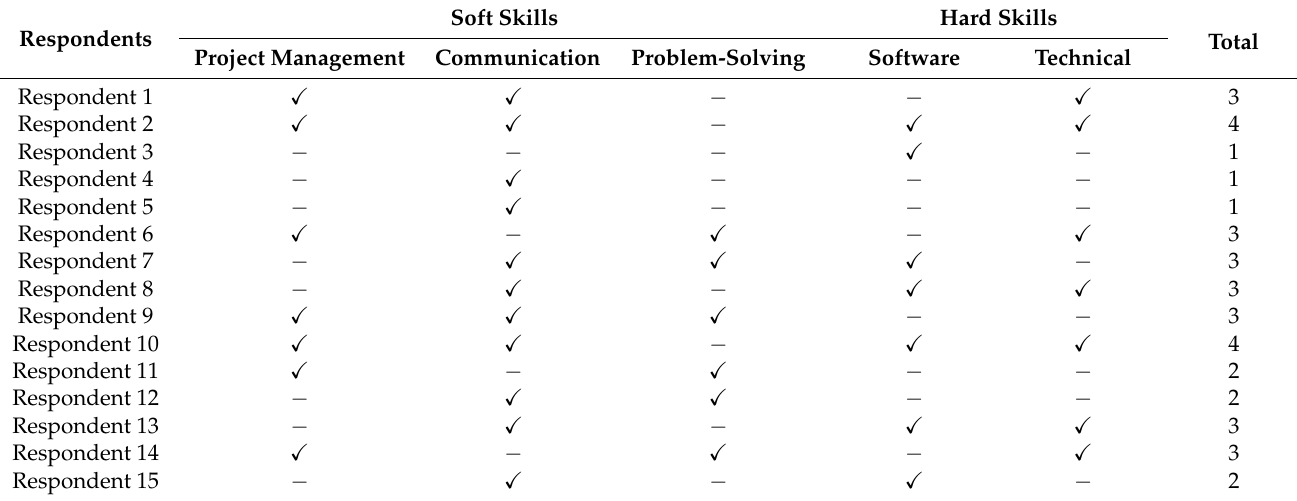
Table 3. Constructive leadership skills in BIM-based construction